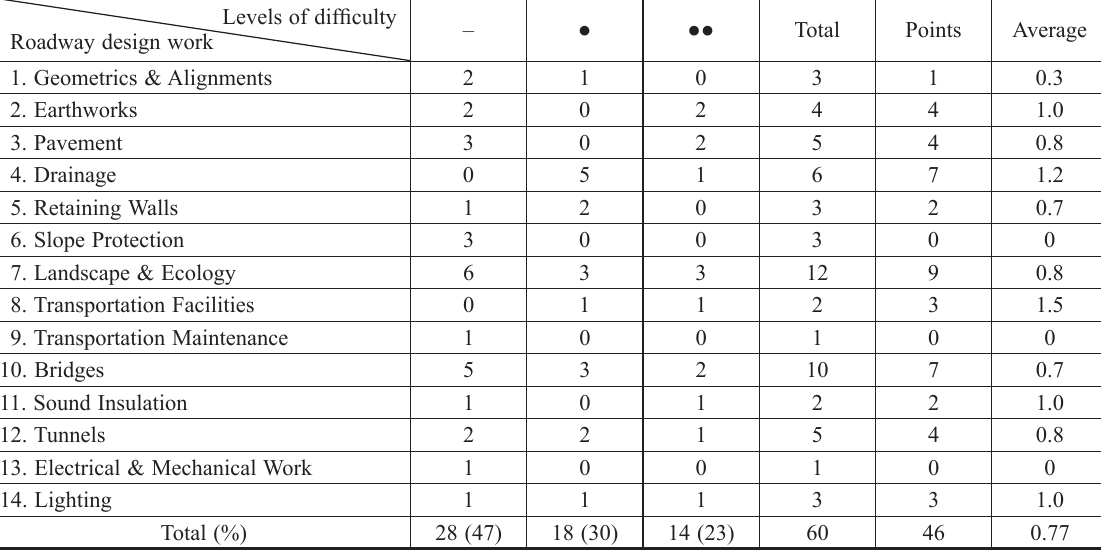
Table 3. Levels of difficulty of roadway design work Levels of difficulty Roadway design